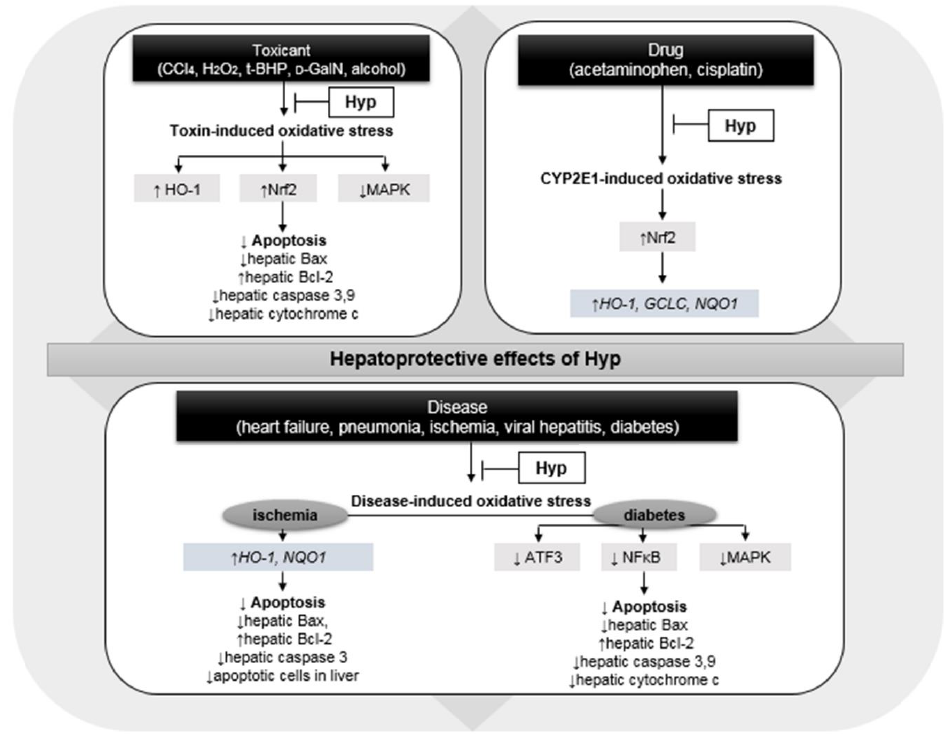
Figure 2. Hepatoprotective effects of hyperoside (Hyp) via the regulation of oxidative stress triggered by toxic chemical, drug, and various diseases; CCl 4 , carbon tetrachloride; H 2 O 2 , hydrogen peroxide; t-BHP, tert-butyl hydroperoxide; D -GalN, D-galactosamine; HO-1, heme oxygenase-1; Nrf2, nuclear factor erythroid 2-related factor 2; MAPK, mitogen-activated protein kinase; Bax, Bcl-2-associated X protein; Bcl-2, B-cell lymphoma 2; GCLC, glutamate-cystein ligase catalytic subunit; NQO1, NAD(P)H quinone dehydrogenase 1; ATF3, cyclic AMP-dependent transcription factor; and NF κ B, nuclear factor kappa B. Upward pointing arrow ( ↑ ) and downward pointing arrow ( ↓ ) represent an increase and a decrease in gene/protein expression or numerical values, respectively. Table 1. Hepatoprotective activities of hyperoside (Hyp) in experimental models related to various liver diseases. Hyperoside/Source Experimental Model Dose Results/Molecular Mechanisms